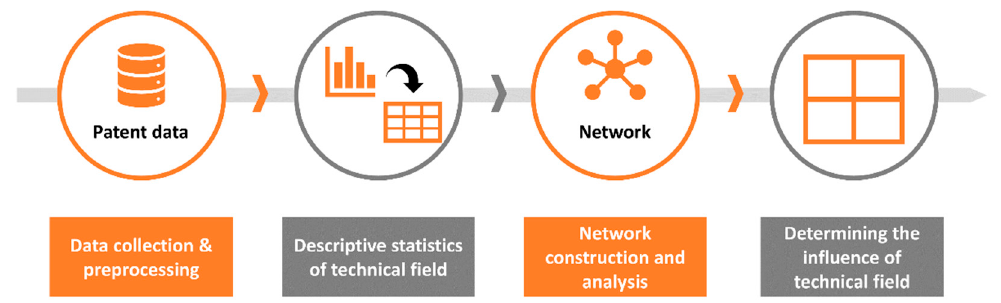
Figure 1. Overview of the analysis framework.